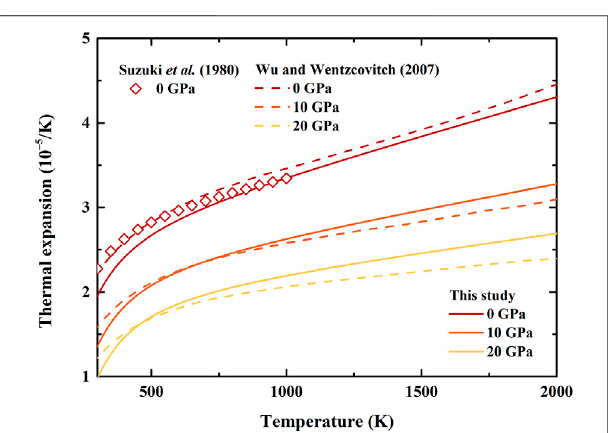
differences are within 0.6%. The obtained adiabatic bulk modulus and shear modulus are 5.4% and 3.5% larger than that of Katsura et al. (2001) and Mayama (2004), respectively. The temperature derivatives of adiabatic bulk modulus and shear modulus are determined as z K S / z T = − 0.0145(1) GPa/K and z G / z T = − 0.0210(1) GPa/K, respectively, which are comparable with those obtained by resonant ultrasound spectroscopy (Katsura et al., 2001; Mayama, 2004; Isaak et al., 2010) ( Table 2 ).